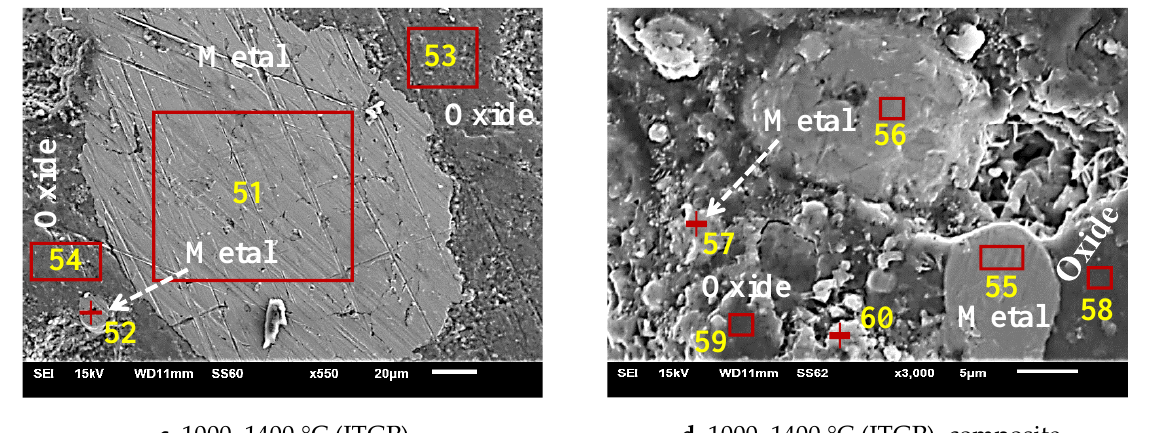
Figure 10. SEM images of roasted natrojarosite residue after carbothermic reduction at different temperatures; ITGP = isothermal temperature gradient profile.